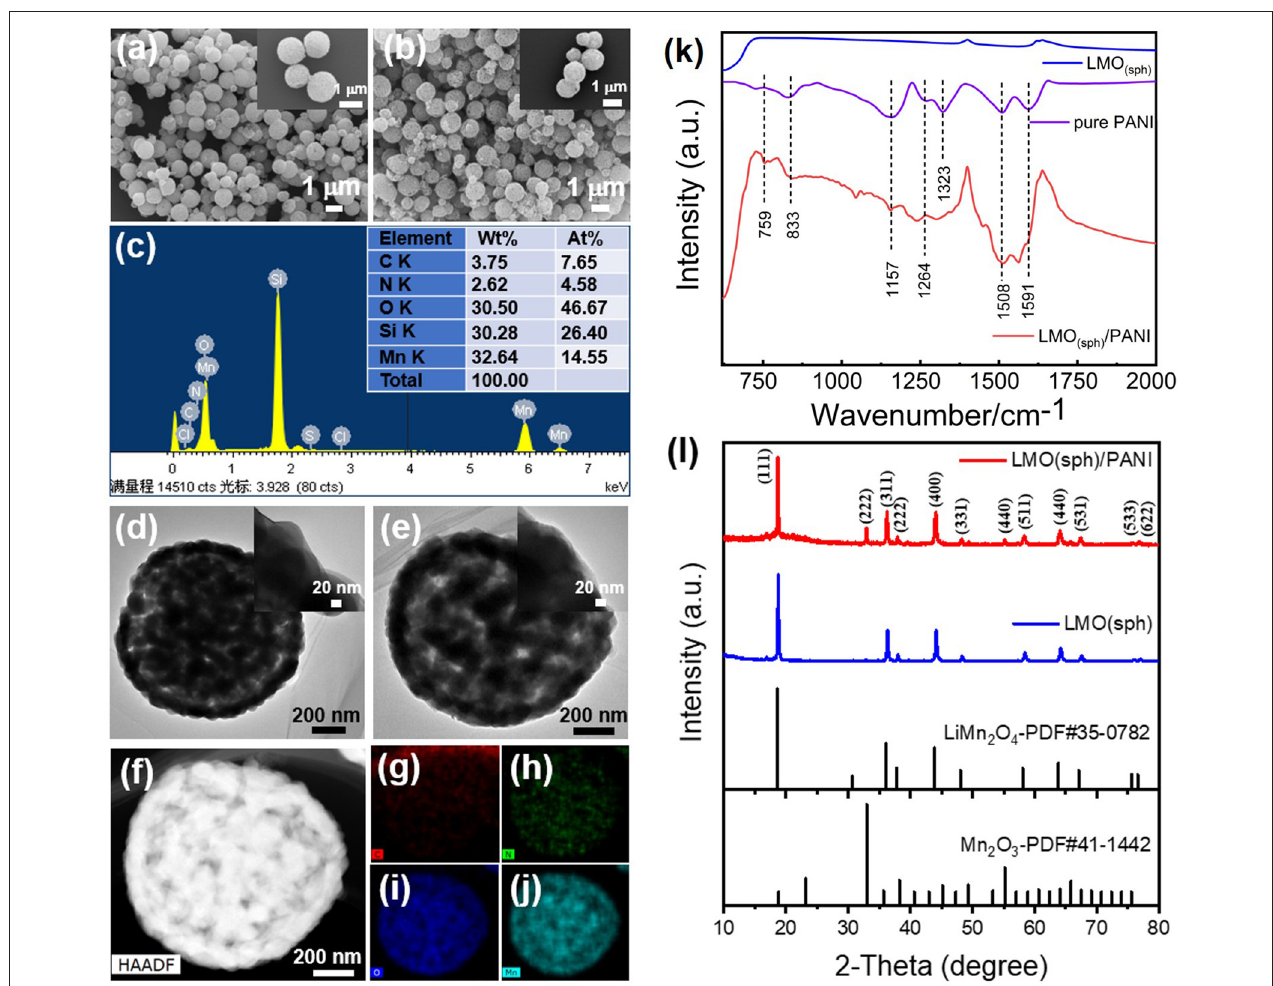
FIGURE 2 | SEM images of (a) LMO (sph) and (b) LMO (sph) /PANI, (c) EDX result of LMO (sph) /PANI. TEM images of (d) LMO (sph) and (e) LMO (sph) /PANI. (f) HAADF image and EDX elemental mapping of (g) C, (h) N, (i) O, and (j) Mn elements taken from LMO (sph) /PANI. (k) FT-IR and (l) XRD of LMO (sph) , pure PANI and LMO (sph)